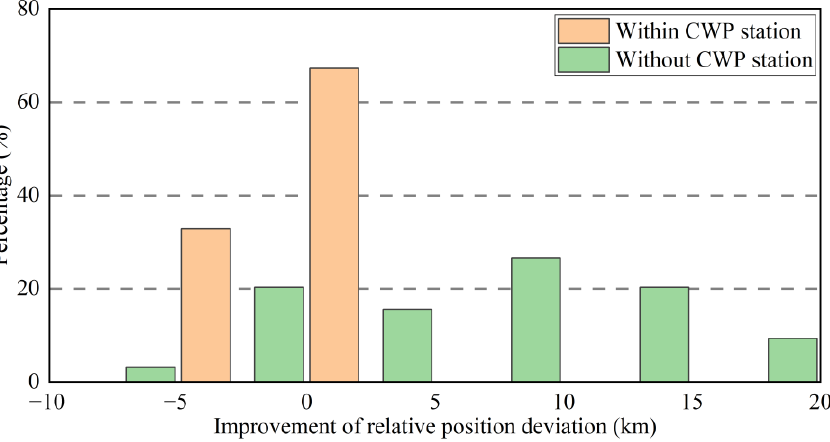
Figure 14. Percentage of relative position deviation improvement before and after eliminating the sferics measured by the CWP station; negative values mean the accuracy is reduced.